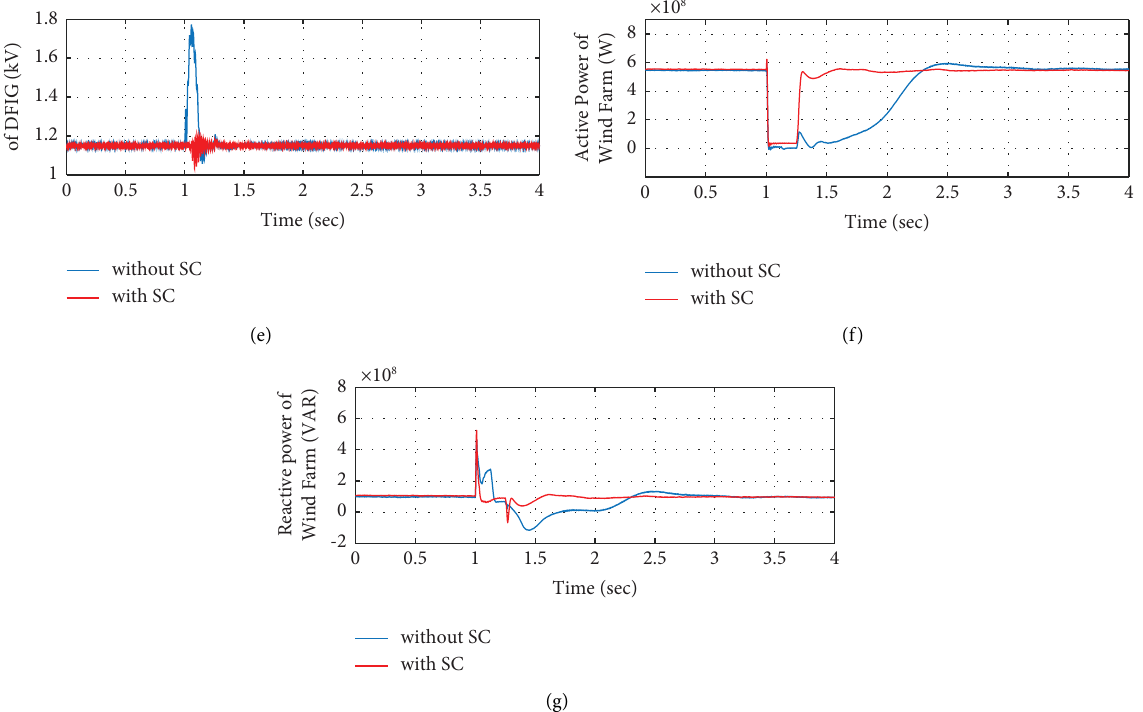
Figure 18: Performance during a three-line-to-ground fault. (a) Te AC voltage at B575, (b) the DC voltage of the APF capacitor, (c) the load active power, (d) the load reactive power, (e) the DC-link voltage of the back-to-back converter, (f) the total active power of the wind farm, and (g) the total reactive power of the wind